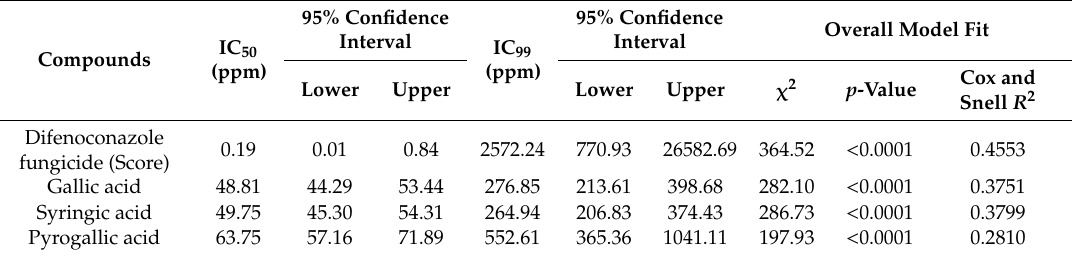
Figure 3. Probit regression (dose–response analysis) of the inhibition effects of gallic acid and its derivatives against A . solani ( n = 6). ( A ) Difenoconazole fungicide, ( B ) gallic acid, ( C ) pyrogallic acid, and ( D ) syringic acid. Probability was calculated for the inhibition of the radial mycelial growth (%) of A. solani after the treatment with different concentrations of gallic acid and its derivatives (0, 20, 40, 60, 80, or 100 ppm). Blue dots present the mean of six replicates of each concentration. The probit regression lines are presented as blue solid-lines. The 95% confidence intervals for the estimated regression are edged by red dashed-lines. Regression equations, Cox and Snell R 2 , and p -value based on the F test ( p ≤ 0.05) were also obtained and presented within the graphs. The experiment was repeated twice with similar results. Table 1. The half-maximal inhibitory concentration (IC 50 ) and IC 99 values (ppm) of difenoconazole fungicide, gallic acid, and its derivatives (syringic acid and pyrogallic acid) against A . solani ( n =